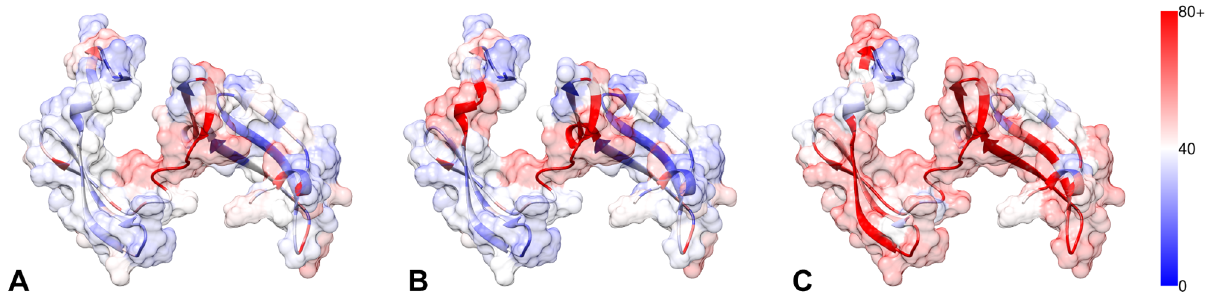
Figure 3. Plots of angular change in DOF s for hinge (A), hinge + flex (B) and auto (C) experiments. Residues are colored by absolute total angular change, with blue indicating a small change and red a large change. Hinge and Flex (A, B) experiments show relatively low activity outside of the planning regions. The automatically guided experiment (C) shows high activity in the hinge and b -sheet regions of both subdomains.